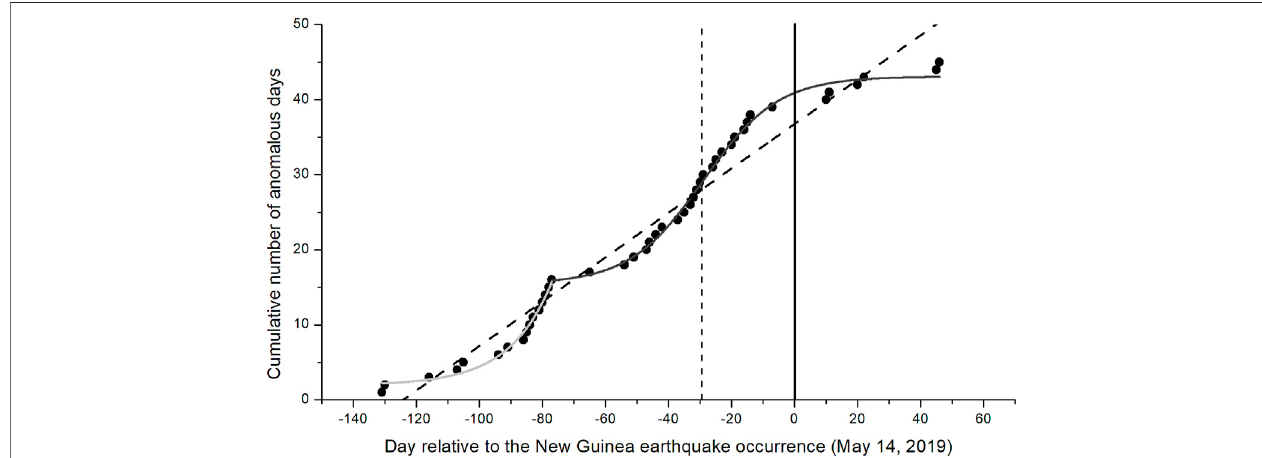
FIGURE 15 | Cumulative number of anomalous days (considering all the Swarm satellites and presented time series) with respect to the day of occurrence of the Papua NewGuineamainshock (negativedays beforetheearthquakeoccurrence, positiveafter).Anomaliesareshown asblack circles,whiledark-and light-graycurves are sigmoidal(Boltzmann) fi ts over two subsequent intervals; the dashed lineis the linear fi t. The verticalblack lineis thetimeofthe earthquake, whilethe vertical dashed line is the in fl ection of the sigmoidal dark-gray